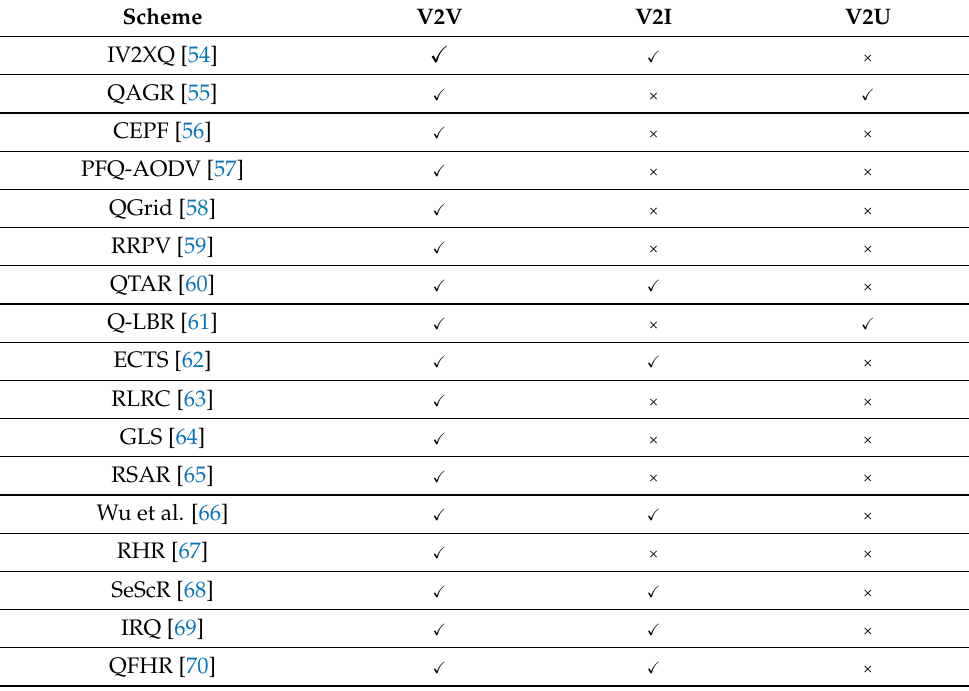
Table 9. Comparison of the routing methods in terms of various communication types.